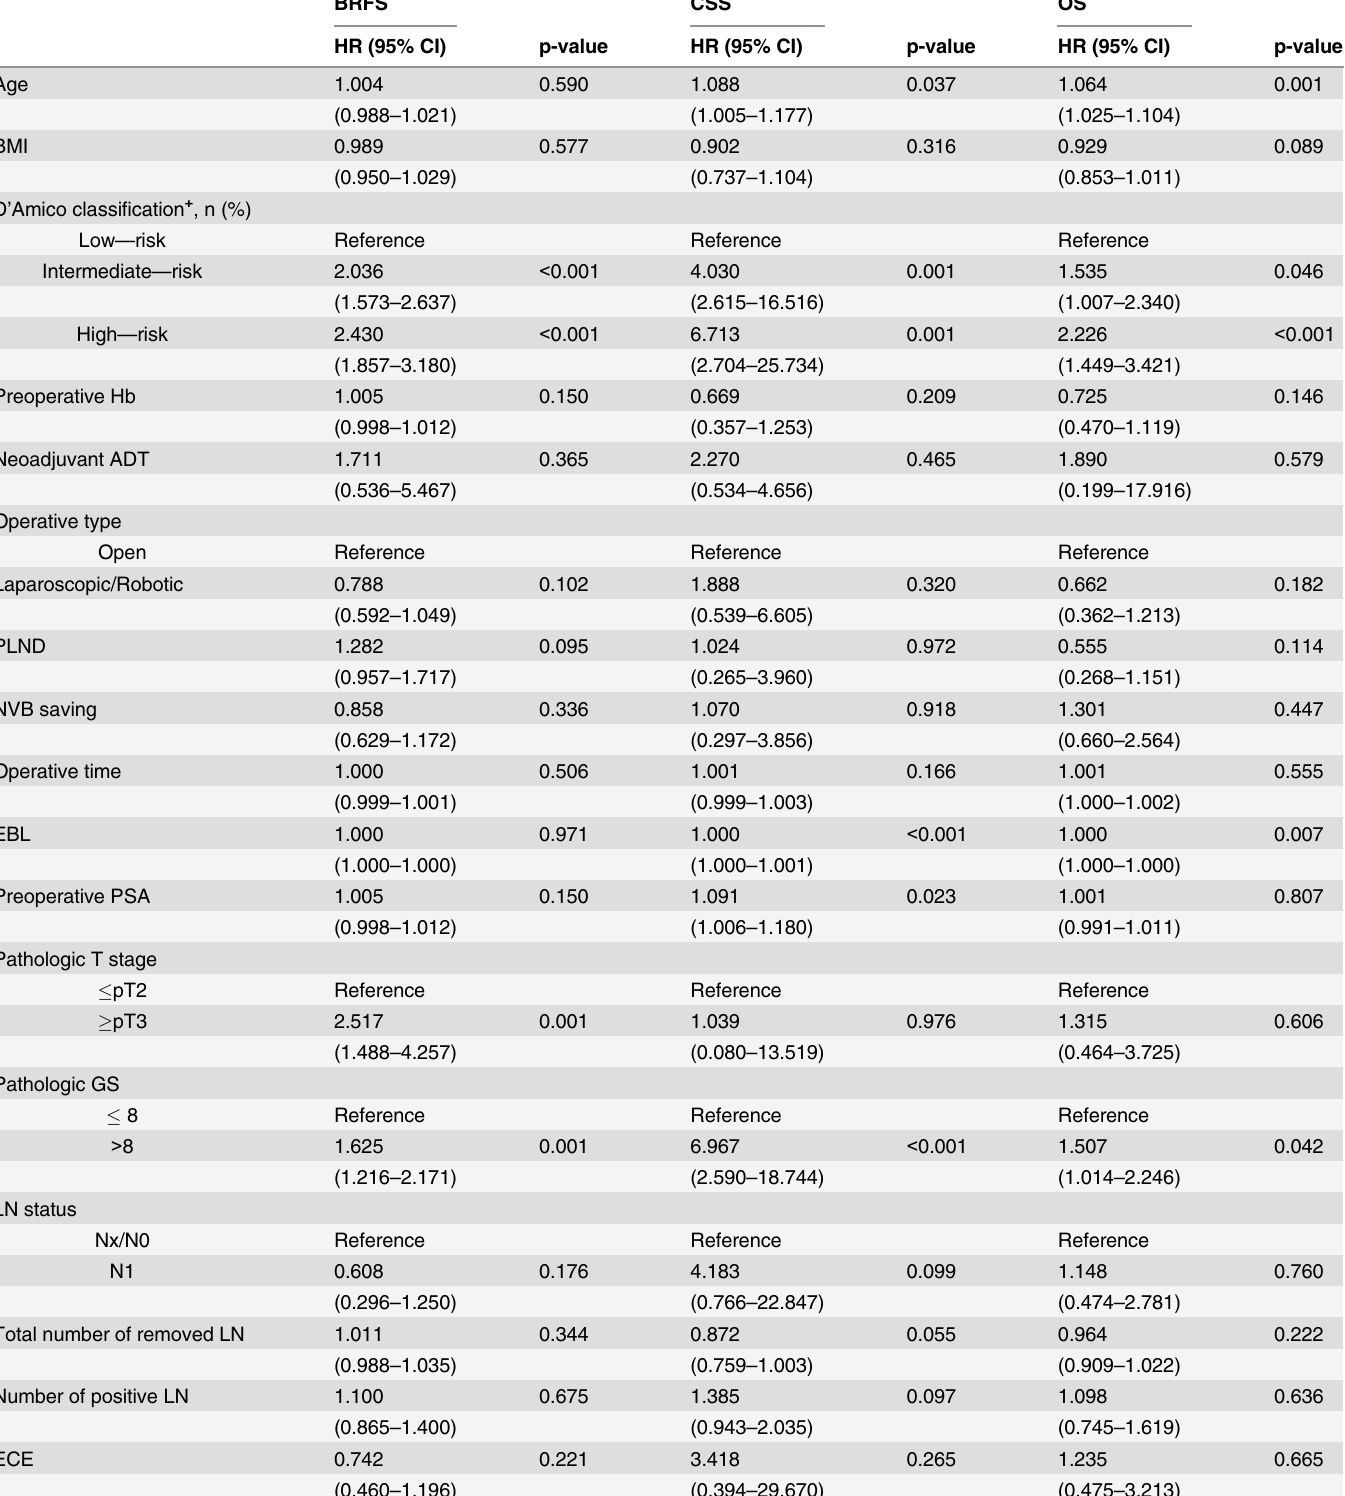
Table 2. Multivariate Cox regression analyses for evaluating variables associated with BCR-free survival (BRFS), cancer-specific survival (CSS), and overall survival